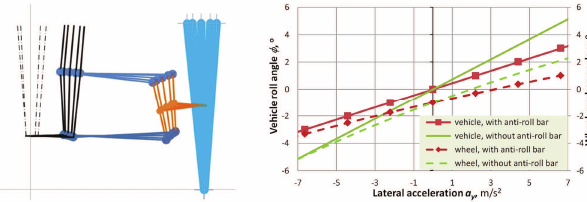
Fig. 3. The wheel camber changing g resulting from vehicle body roll angle f equipped with suspension with double wishbone [own research]